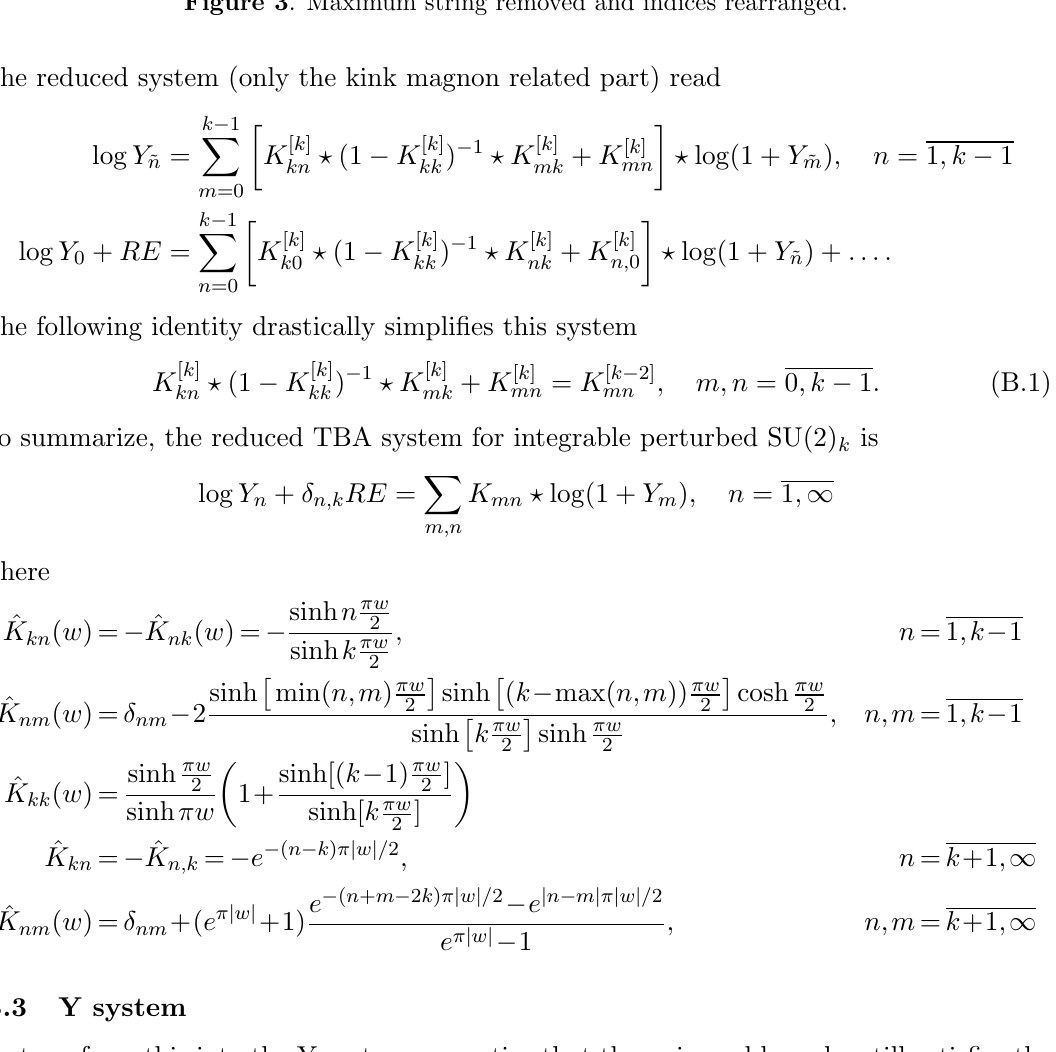
Figure 3 . Maximum string removed and indices